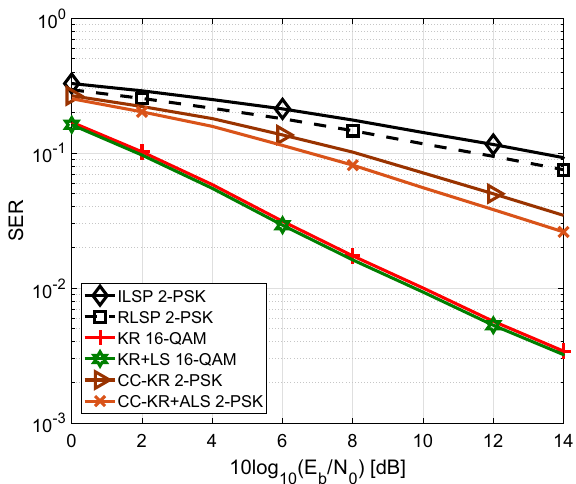
Fig. 7 SER for 4 × 4 KR-coded OFDM, cross-coded OFDM, and traditional OFDM